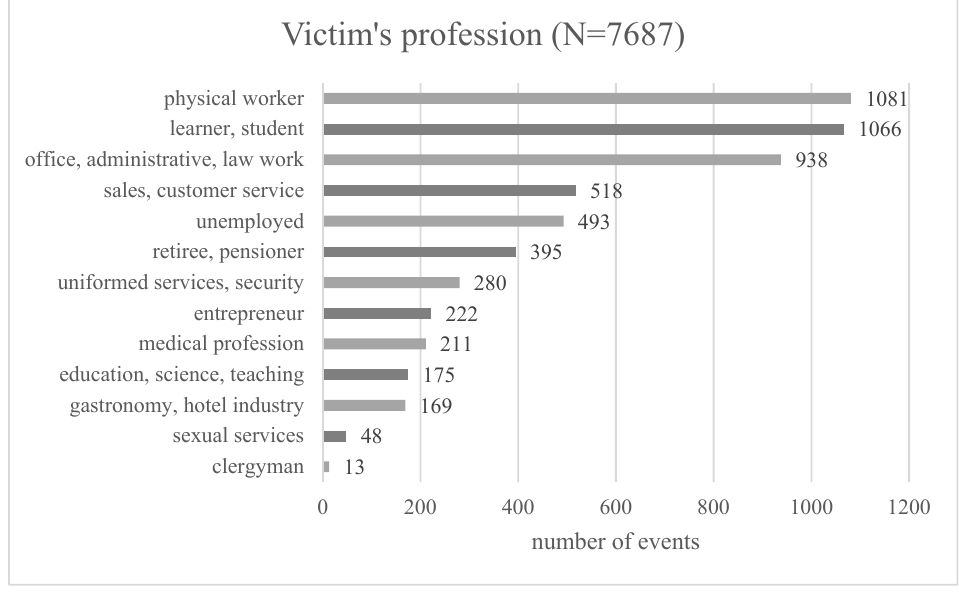
Figure 2. Victim’s occupation.